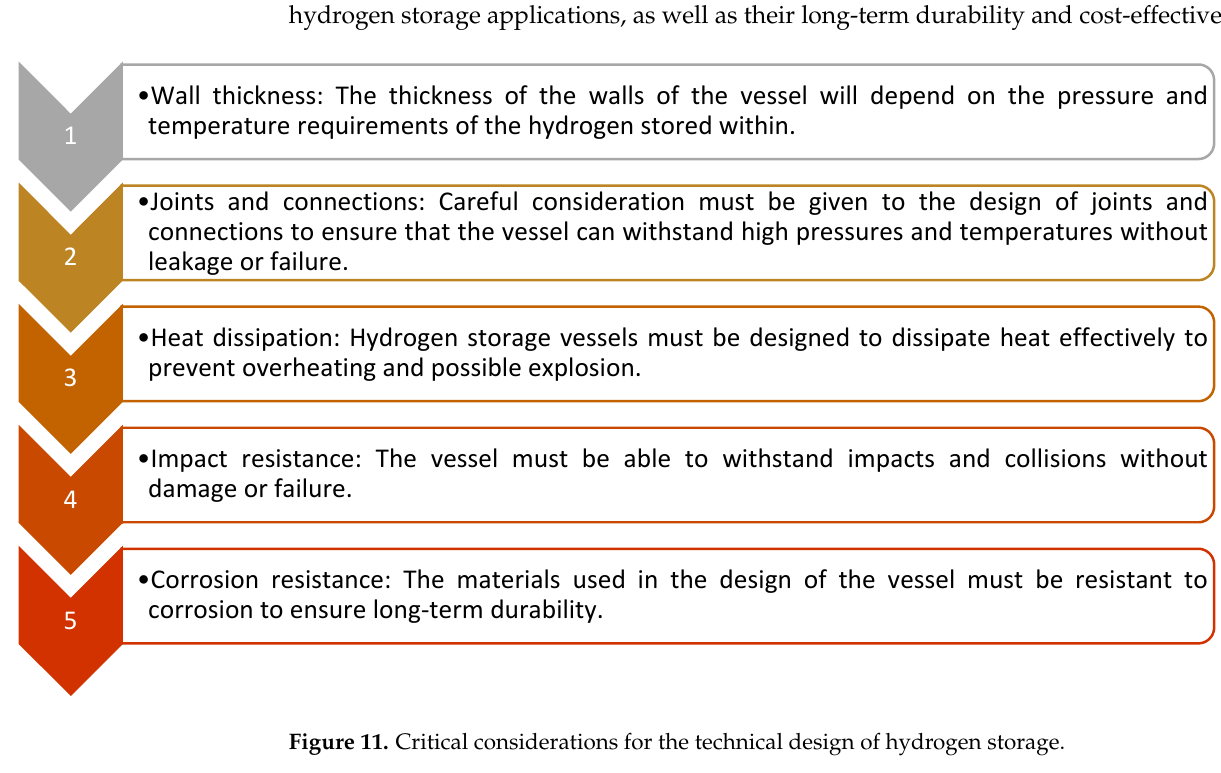
Figure 11. Critical considerations for the technical design of hydrogen storage.